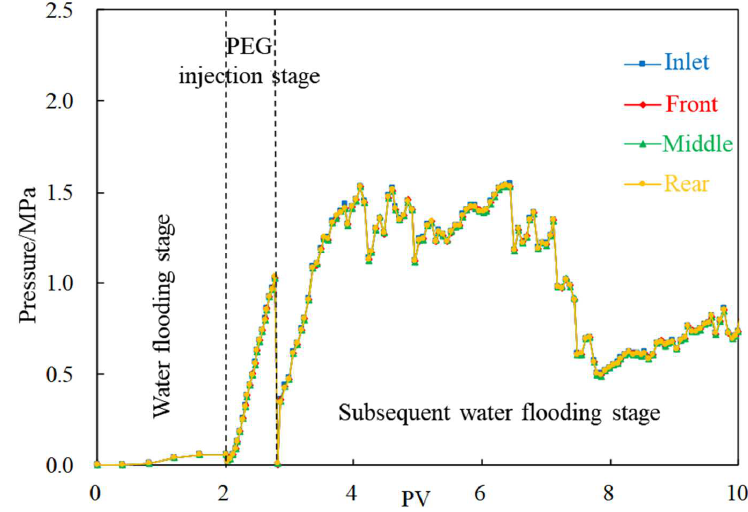
Gels 2022 , 8 , x FOR PEER REVIEW Figure 7. Pressure change curve (injection rate is 0.1 mL/min). Figure 7. Pressure change curve (injection rate is 0.1 mL/min).